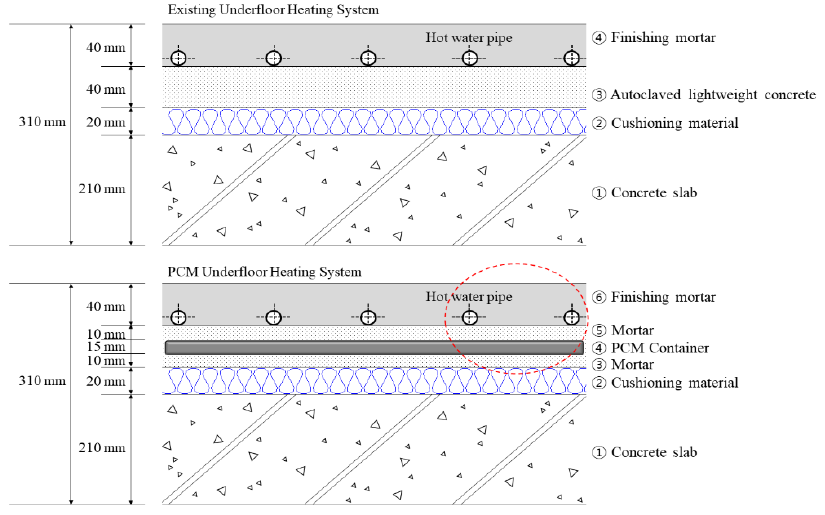
Figure 4. Design of the proposed PCM-based radiant floor heating system structure.